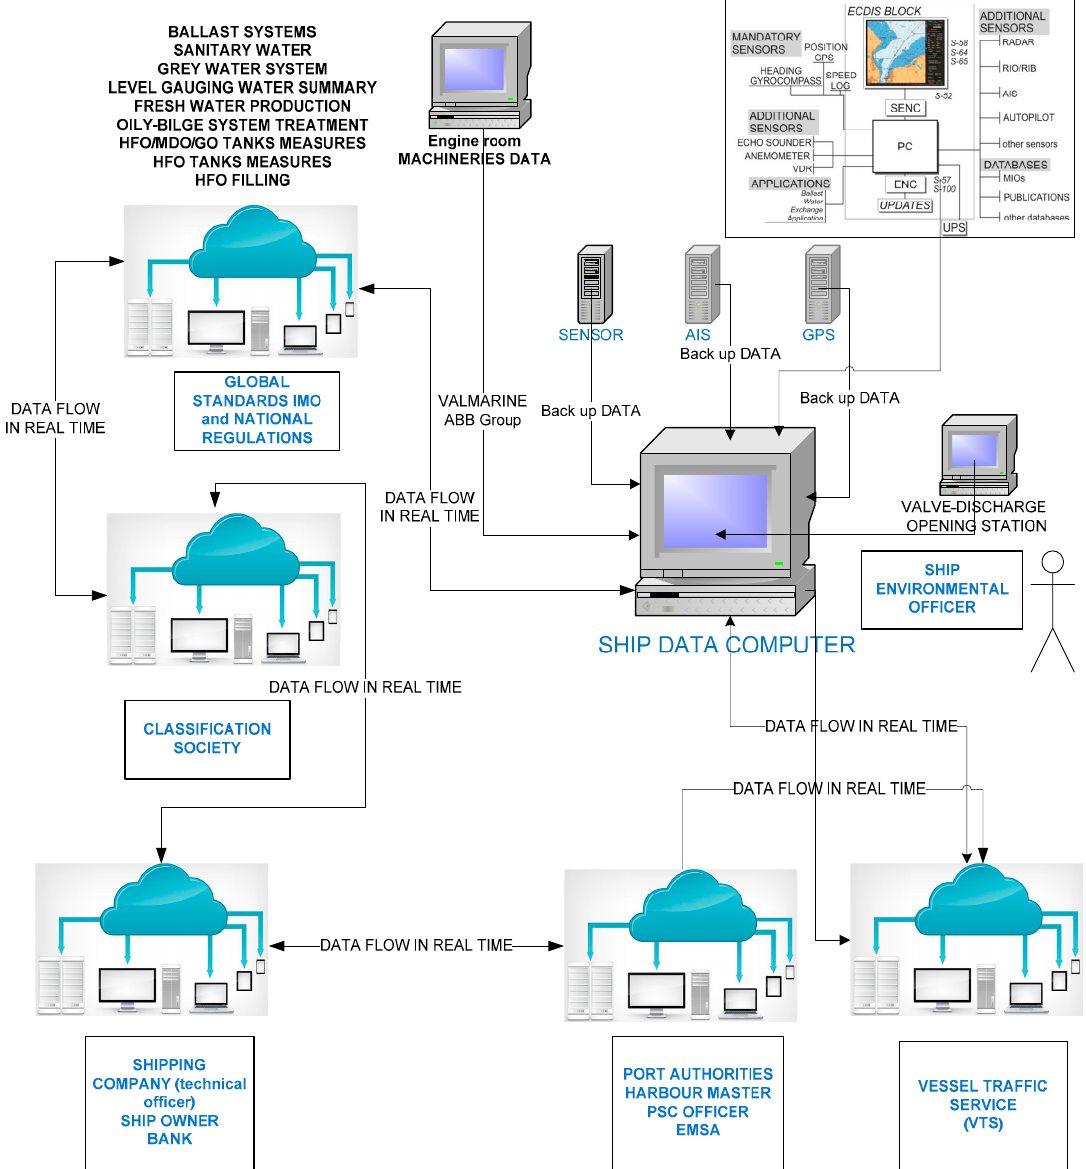
Figure 4. Simplified version of a blockchain network for environmental protection. Source: authors.